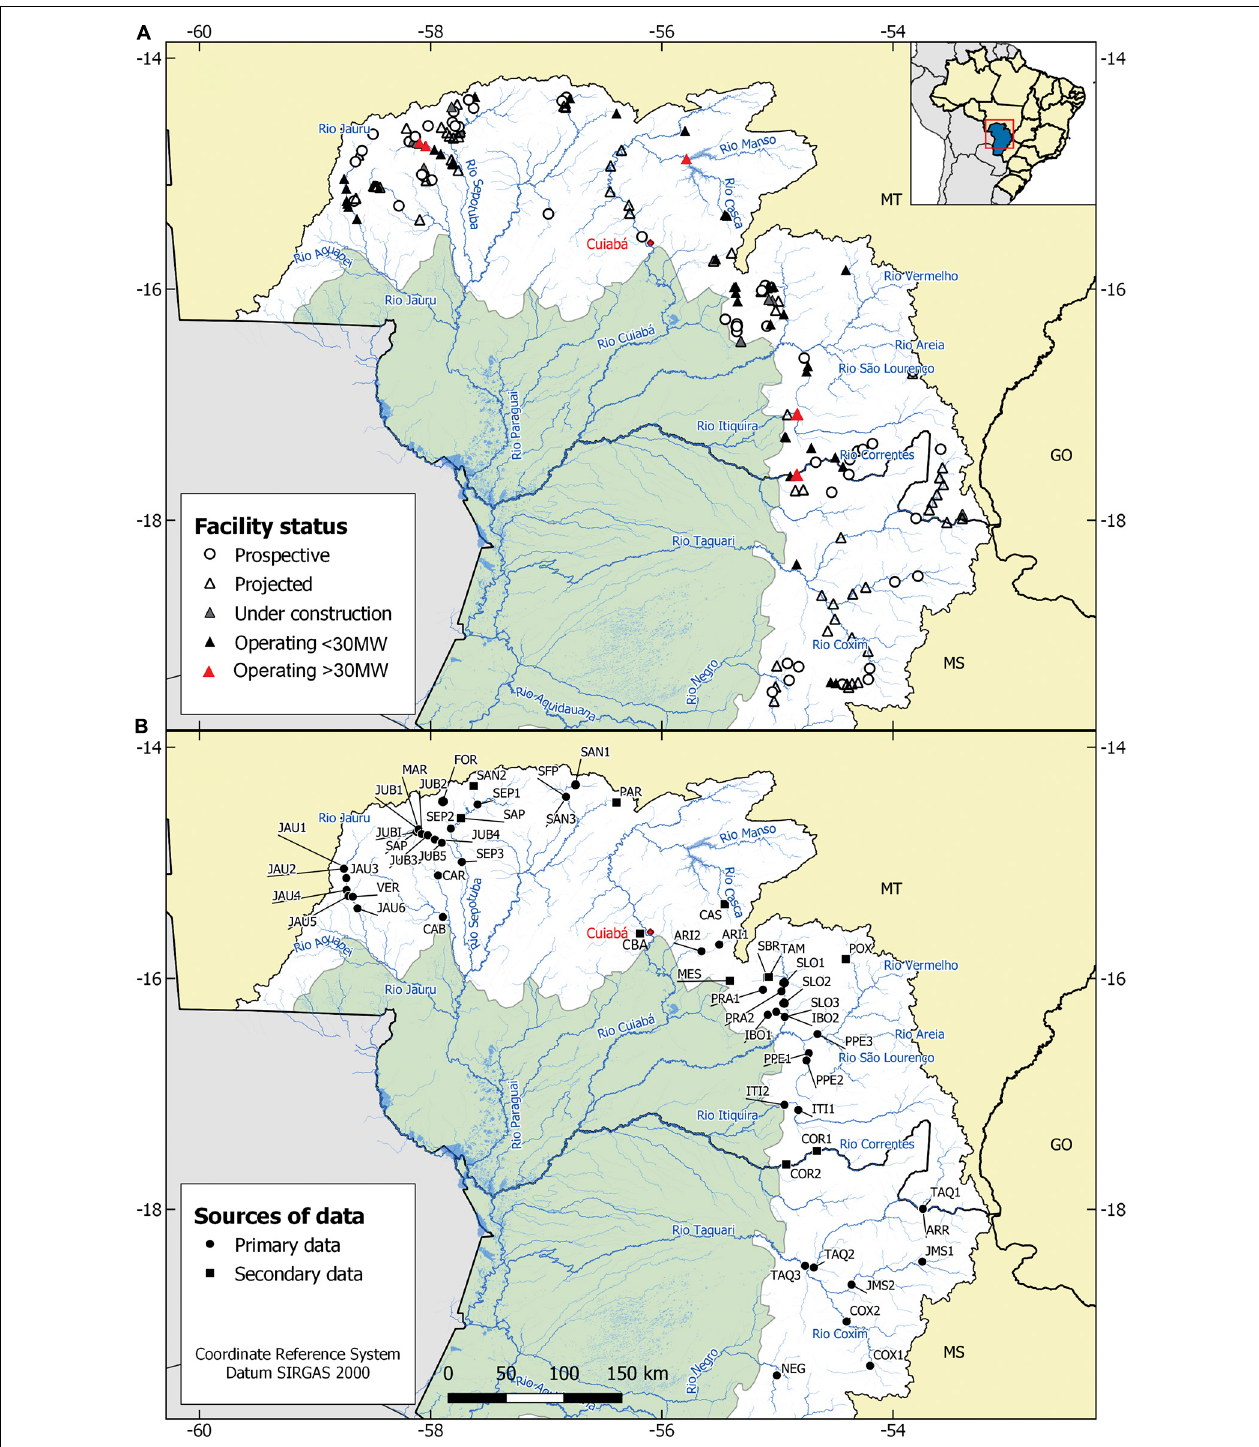
FIGURE 1 | (A) Hydropower facilities in the upland watershed of the Pantanal that are currently in operation as well as future projects that are under construction, planned, or identified as potential sites for hydropower development by either the Brazilian National Electric Energy Agency (ANEEL) or the state environmental agencies (depending on location). Red triangles indicate the four studied facilities with installed capacities > 30 MW. (B) Sampling sites for sediment transport, including sampling conducted by the authors (primary data) as well as secondary data derived from environmental compliance reports submitted to state agencies (SEMA-MT and IMASUL) and from previous scientific studies. The Pantanal floodplains are shaded in green and rivers ( rios ) and other water bodies are shown in blue. Sampling site codes are identified in Table 1 .